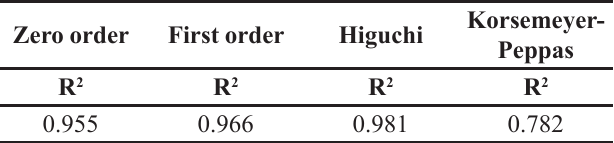
TABLE X - Drug release kinetics Zero order